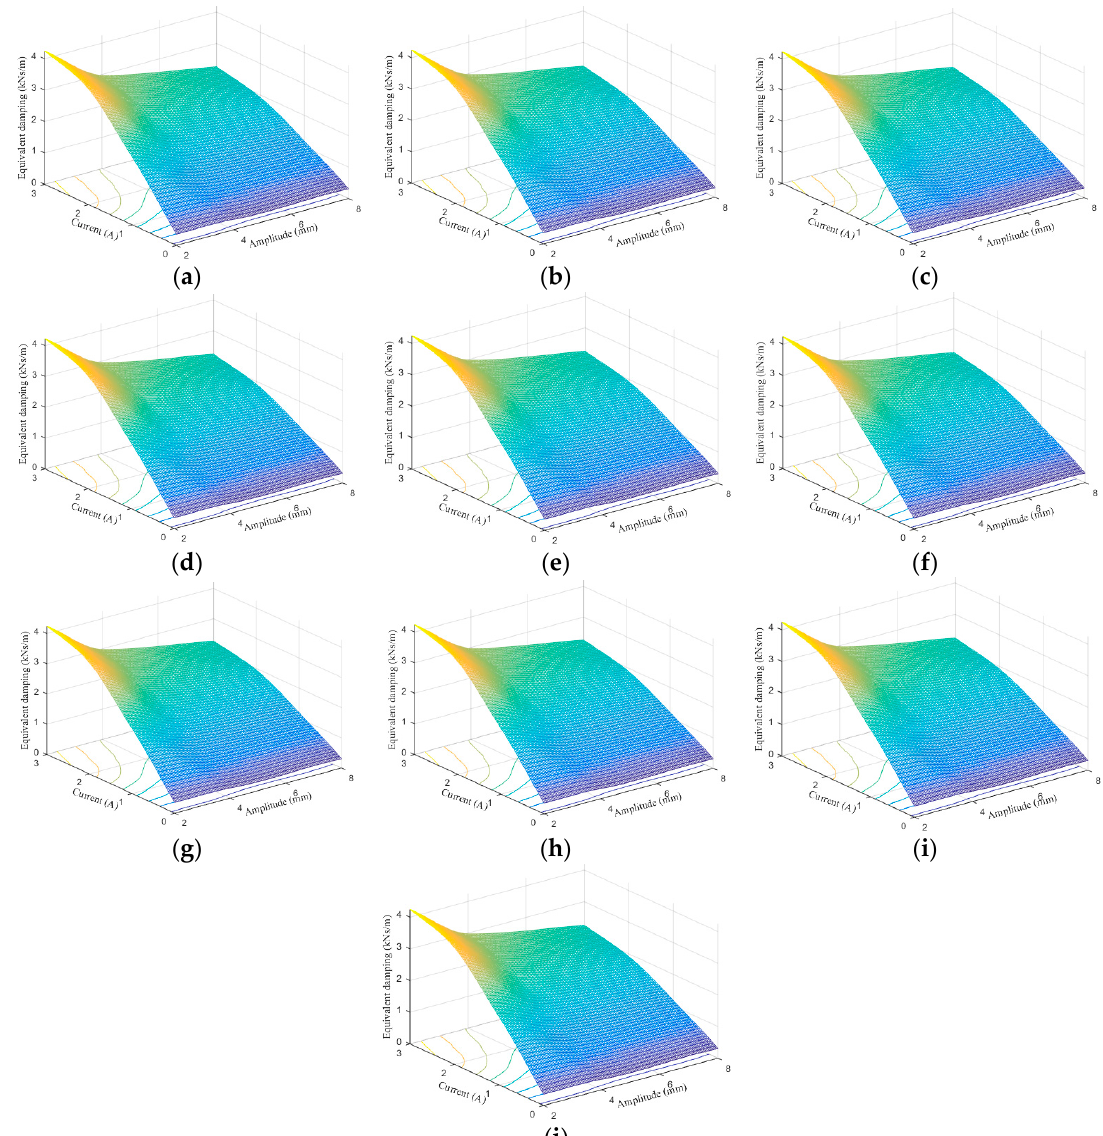
Figure 27. Equivalent damping estimation results of 0.1 Hz loading frequency. ( a ) Experimental measurement, ( b ) Kelvin–Voigt model, ( c ) four-parameter viscoelastic model, ( d ) rheological model, ( e ) BW model, ( f ) improved BW model, ( g ) Dahl model, ( h ) improved LuGre friction model, ( i ) strain stiffening model, and ( j ) hyperbolic hysteresis model.